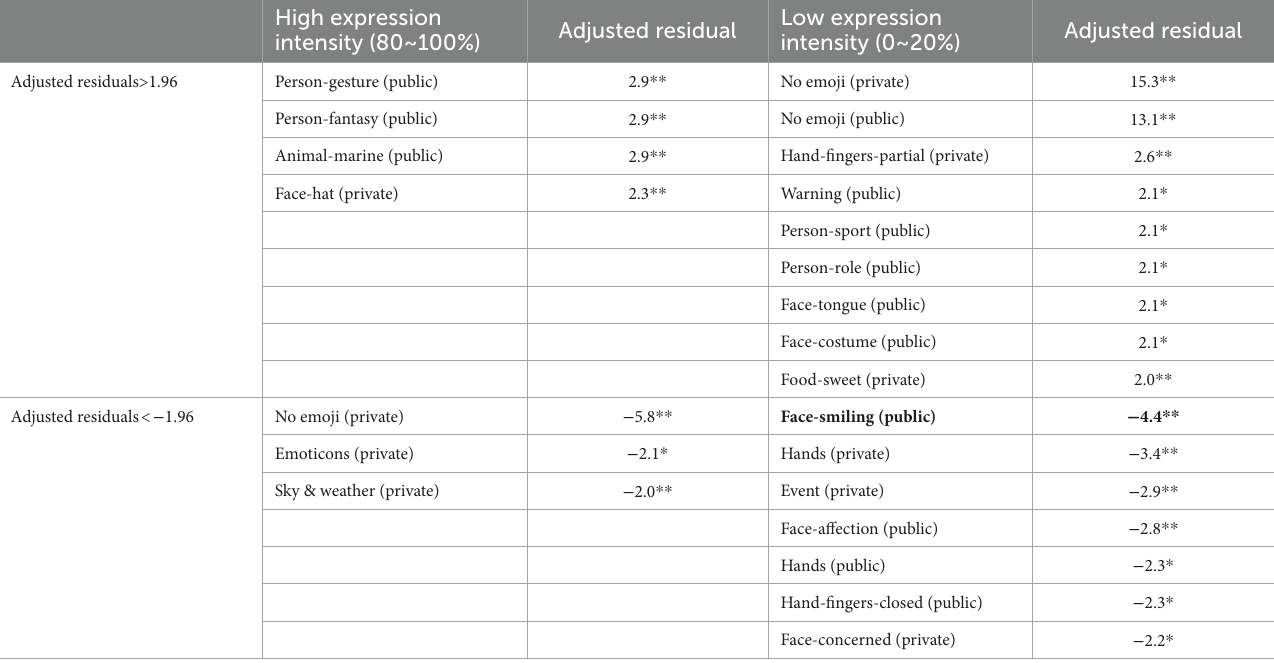
* p < 0.05; ** p < 0.01; ( p < 0.01 for adjusted residual > |2.58| and p < 0.05 for adjusted residual > |1.96|). TABLE 6 Residual analysis of emoji categories and emotional expression in negative contexts. High expression Low expression Adjusted residual Adjusted residual intensity (80 ~ 100%) intensity (0 ~ 20%) Adjusted residuals > 1.96